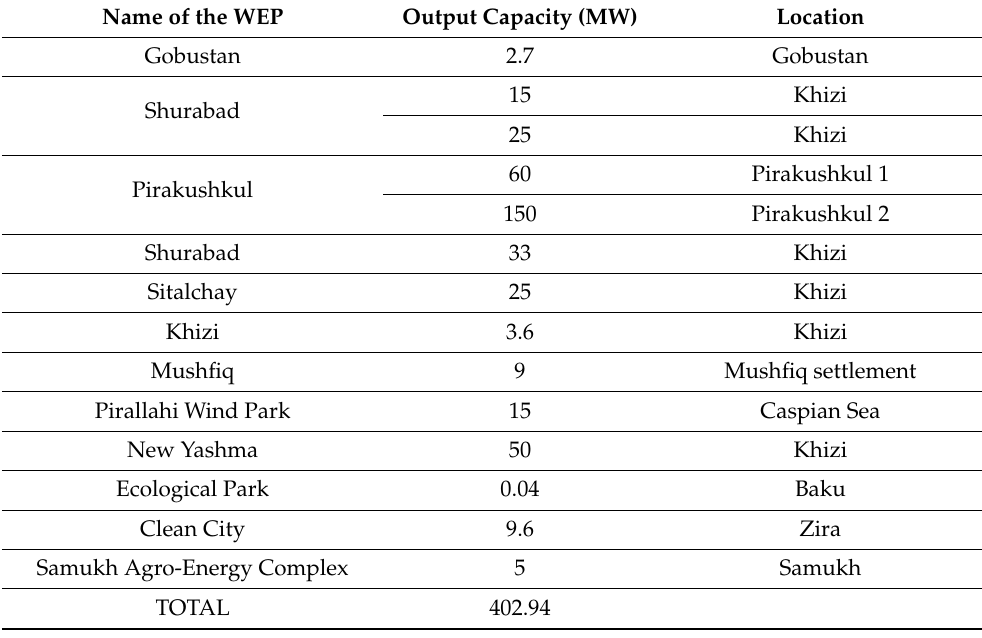
Table 4. List of installed and envisaged wind energy plants (WEPs) in Azerbaijan in 2014 [7].